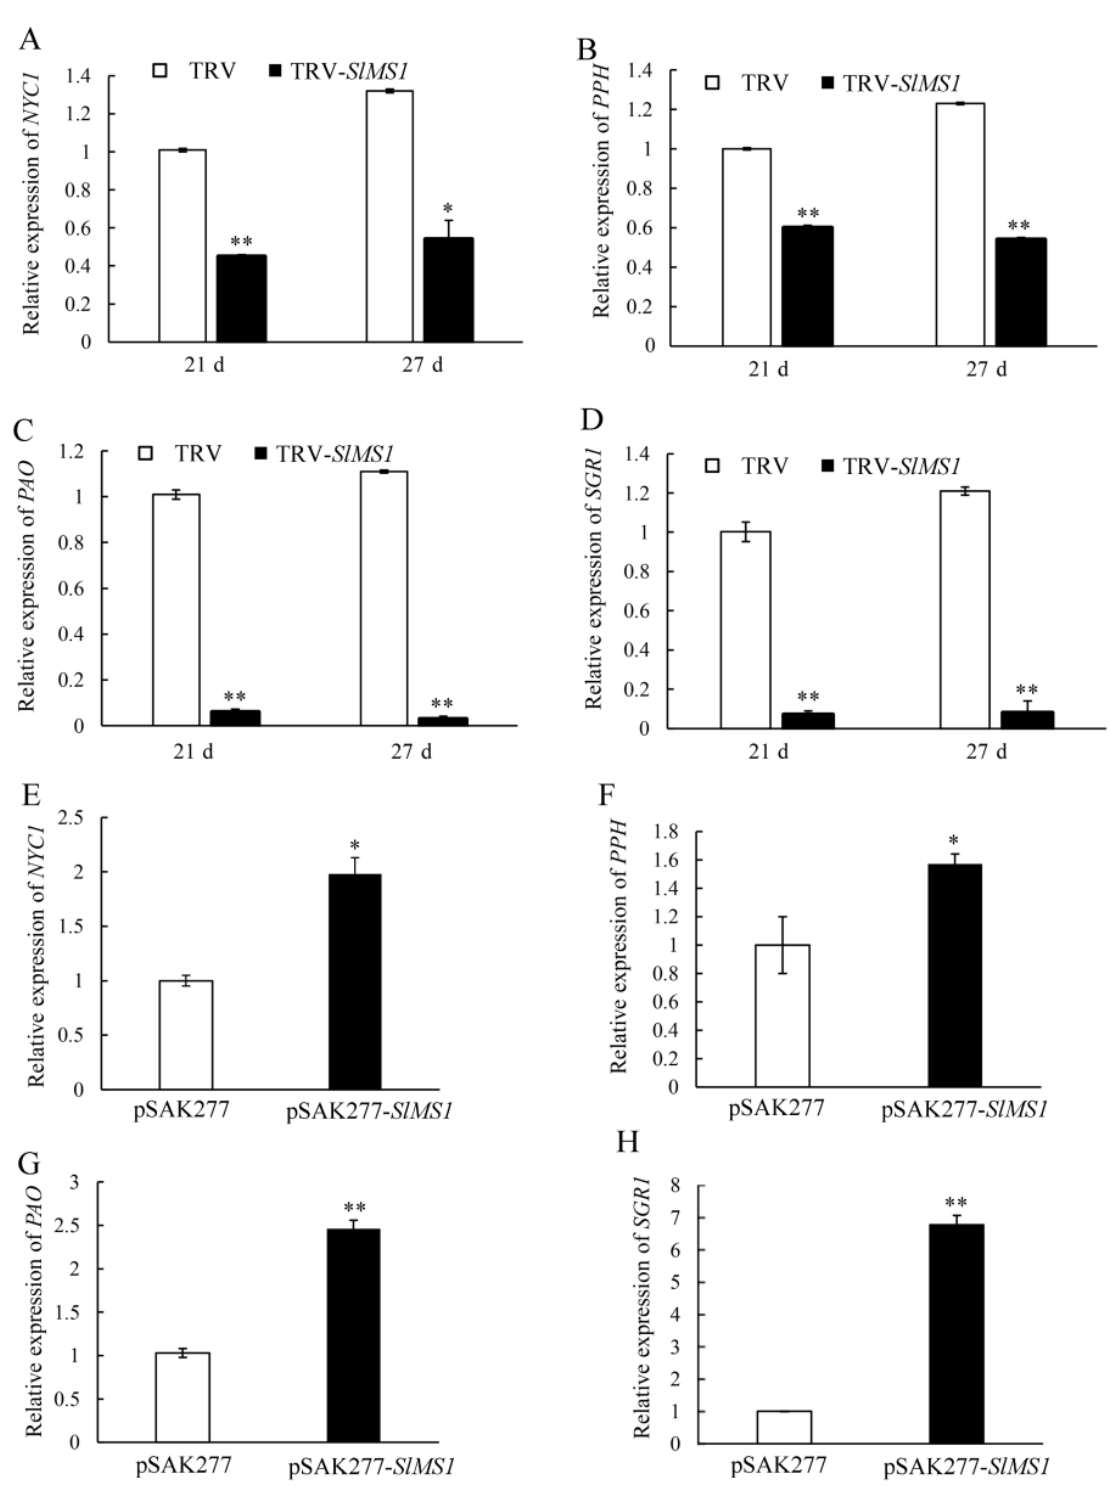
Figure 6. Effect of transient silencing and transient overexpression of SlMS1 on gene expression of chlorophyll degradation related genes NYC1 , PPH , PAO and SGR1 in tomato fruit. (A-D) Relative gene expression of NYC1 ( A ), PPH ( B ), PAO ( C ) and SGR1 ( D ) in control (TRV) and SlMS1 -silenced fruit (TRV- SlMS1 ) at 21 and 27 days post inoculation. (E-H) Relative gene expression of NYC1 ( E ), PPH ( F ), PAO ( G ) and SGR1 ( H ) in control (pSAK277) and SlMS1 -overexpressed (pSAK277- SlMS1 ) fruit at 10 days post inoculation. The symbols * and ** stand for p < 0.05 and p < 0.01, as determined by Stude nt’s t -test, respectively.